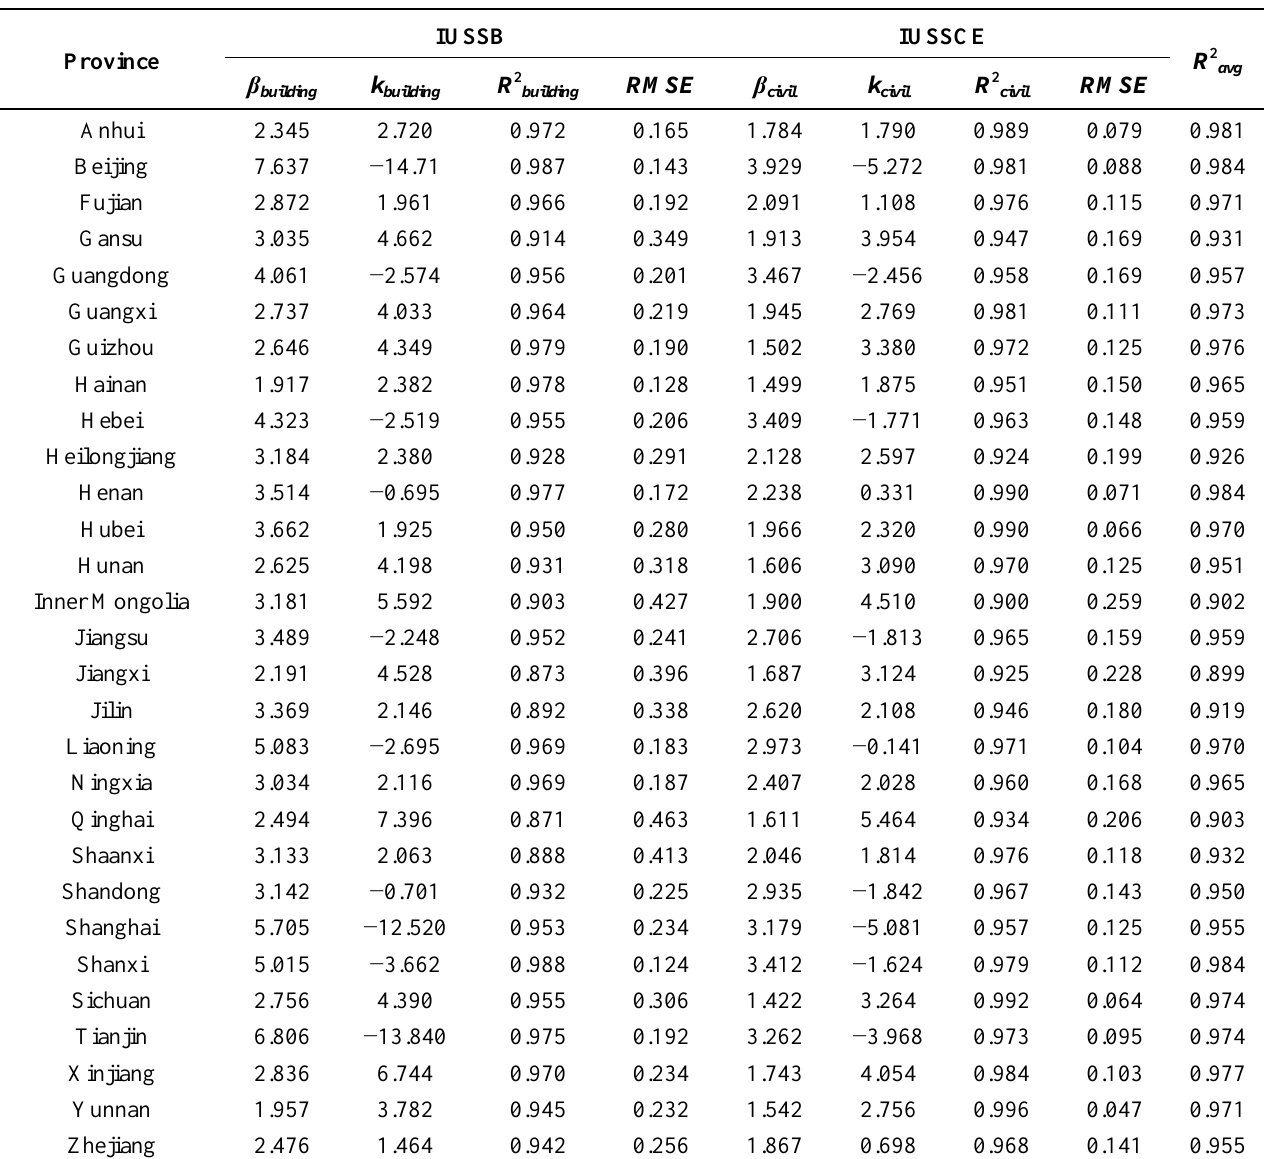
Table 2. Time-series regression results for IUSSB and IUSSCE. R 2 average of R 2 and R 2 building civil